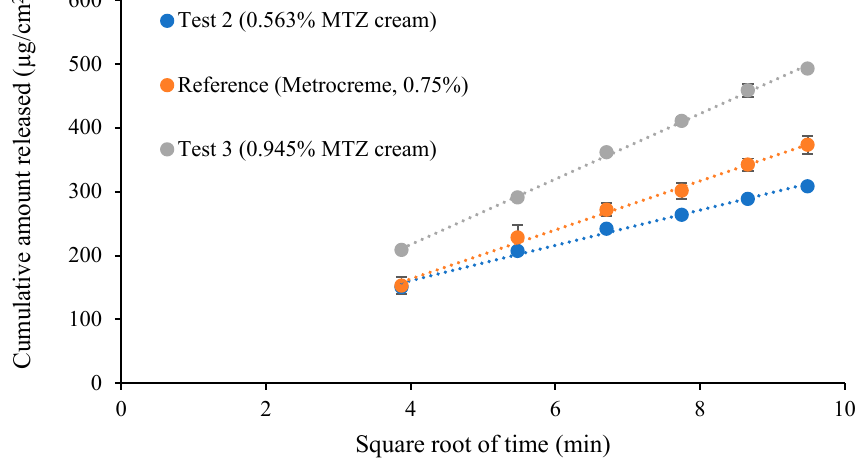
Figure 3. Release-rate curves from 0.563% and 0.945% MTZ cream (T 2 and T 3 ) vs. Metrocreme ® , 0.75% MTZ (R) ( n = 6).